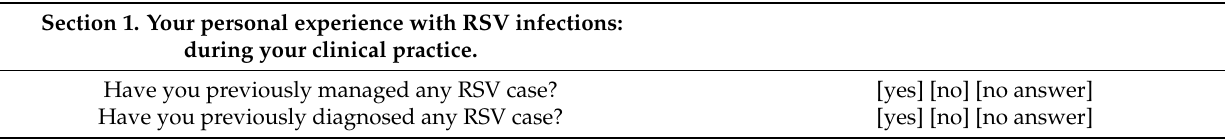
Table A1. Authors’ translation of the items included in the